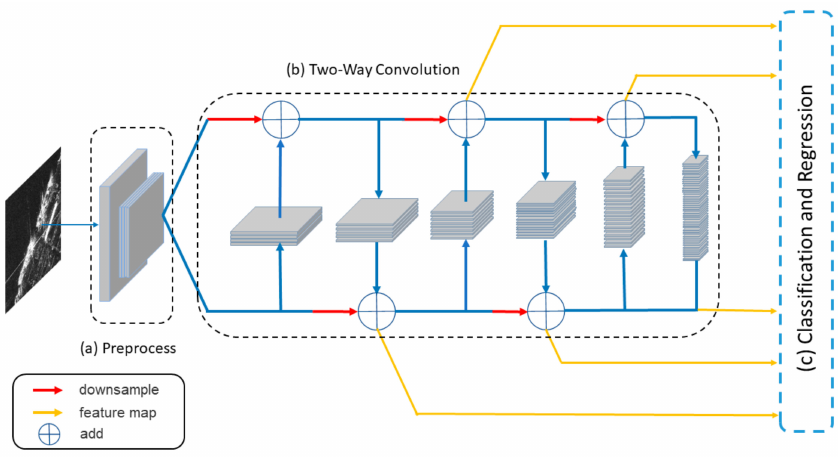
Figure 1. Overall framework of